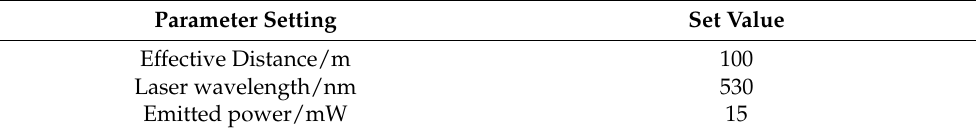
Table 2. Laser emitter parameters.